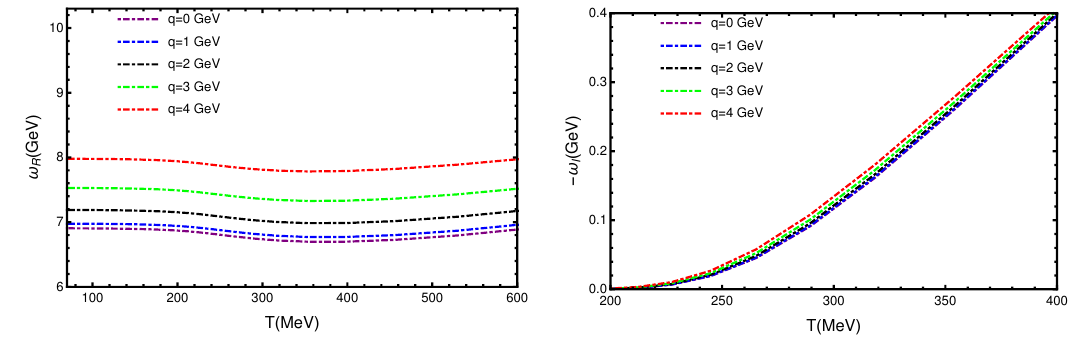
Figure 10 . Numerical results for the quasinormal modes of the bottomonium in the transverse direction as function of the